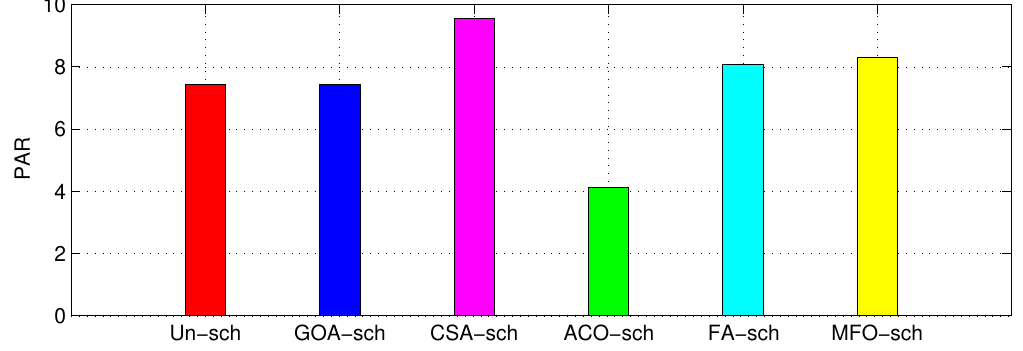
Figure 7. Peak-to-average ratio